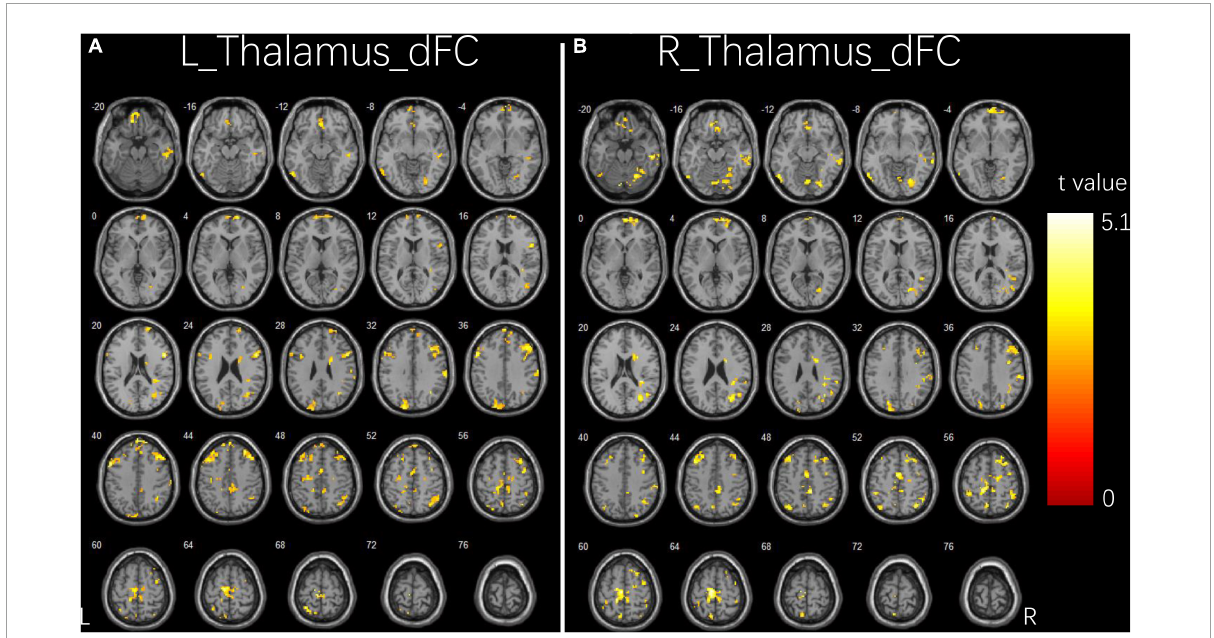
FIGURE2 Group differences in dFC variability for bilateral thalamus seeds between two groups. (A) Brain regions showing significant differences in dFC variability for left thalamus seed. (B) Brain regions showing significant differences in dFC variability for right thalamus seed. The comparison analysis was thresholded at p < 0.005, AlphaSim corrected. R, right hemisphere; L, left hemisphere; dFC, dynamic functional